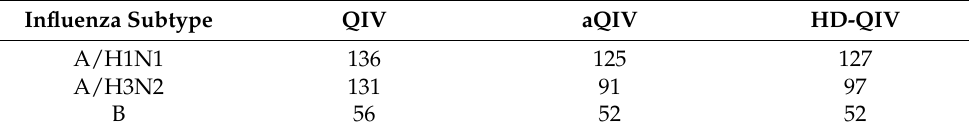
Table 5. Number needed to vaccinate (NNV) for QIV, aQIV, and HD-QIV. Influenza Subtype QIV aQIV